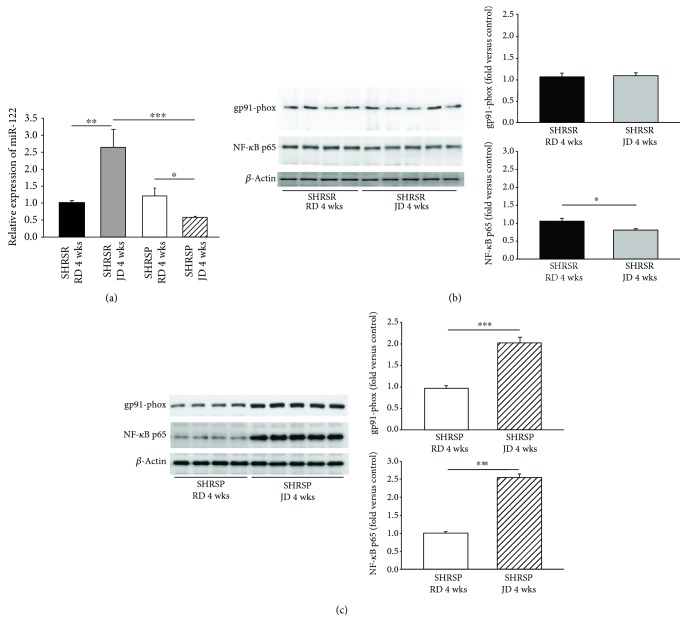
Characterization of brain expression level of microRNA-122, gp 91-phox, and NF-kB protein expression levels in JD-fed versus RD-fed SHRSR and SHRSP strains. (a) miR-122 expression level, as detected by RT-PCR, in the brains of RD- and JD-fed SHRSR and SHRSP; ∗p < 0.05 JD- versus RD-fed SHRSP; ∗∗p < 0.001 JD- versus RD-fed SHRSR; ∗∗∗p < 0.0001 JD-fed SHRSR versus JD-fed SHRSP. (b) Protein expression level of gp91-phox and of NF-kB in SHRSR upon the two diets; ∗p < 0.05 JD- versus RD-fed SHRSR; (c) protein expression level of gp91-phox and of NF-kB in SHRSP upon the two diets. ∗∗∗p < 0.0001 JD- versus RD-fed SHRSP. Representative Western blots and corresponding densitometric analysis are shown in panels (a) and (b). JD = high-salt Japanese style diet; RD = regular diet. N = 8 for each experimental group.